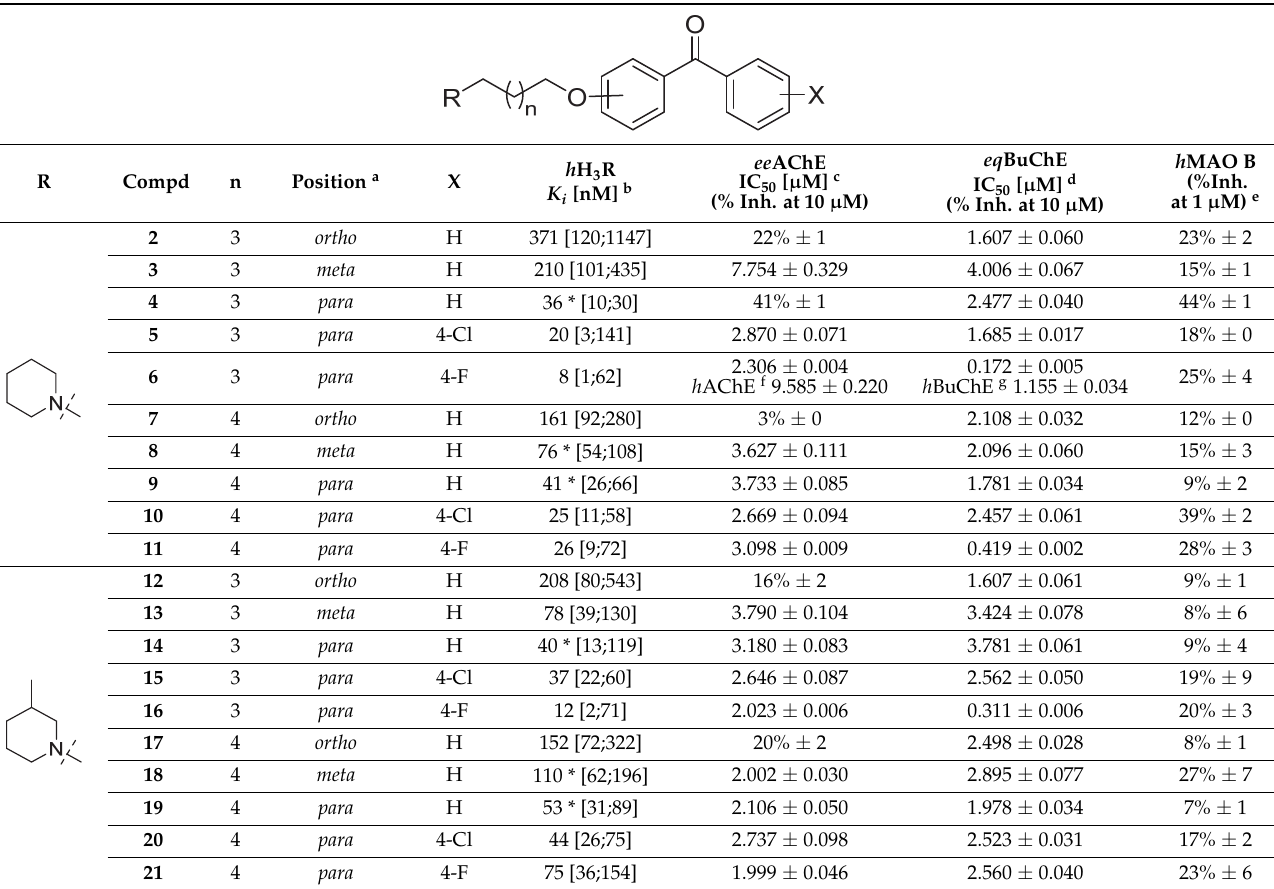
Table 1. Structures and in vitro activity of tested compounds ( 2 – 35 ).